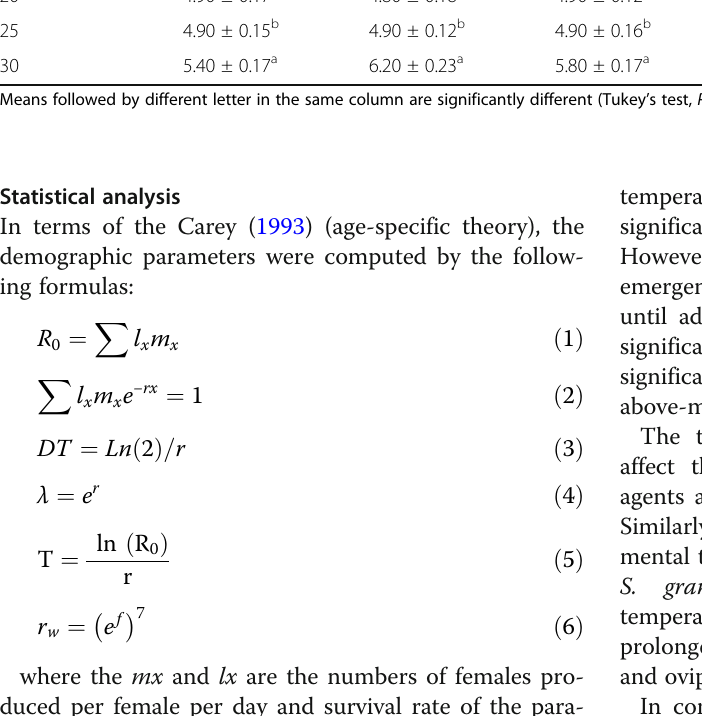
Table 1 Development time (mean ± SE) of Aphidius matricariae parasitizing Schizaphis graminum at various temperatures Temperature (°C)